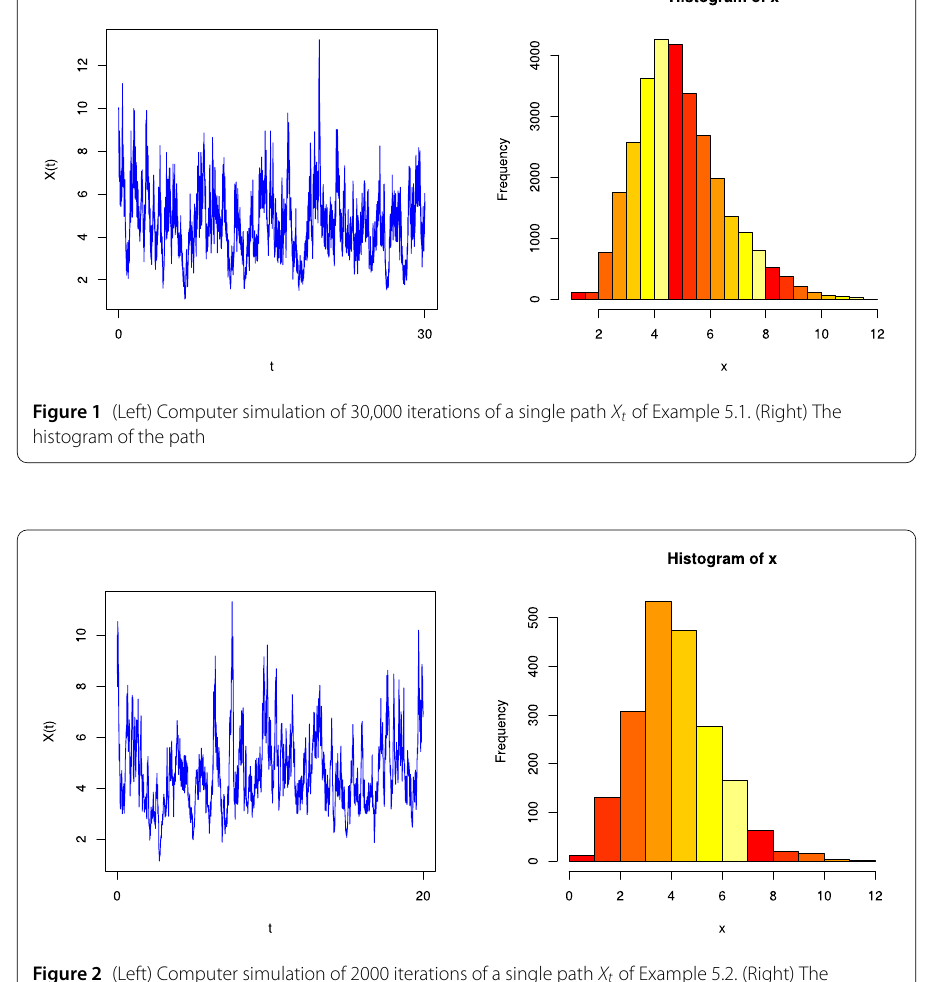
Figure 2 (Left) Computer simulation of 2000 iterations of a single path X t of Example 5.2. (Right) The histogram of the